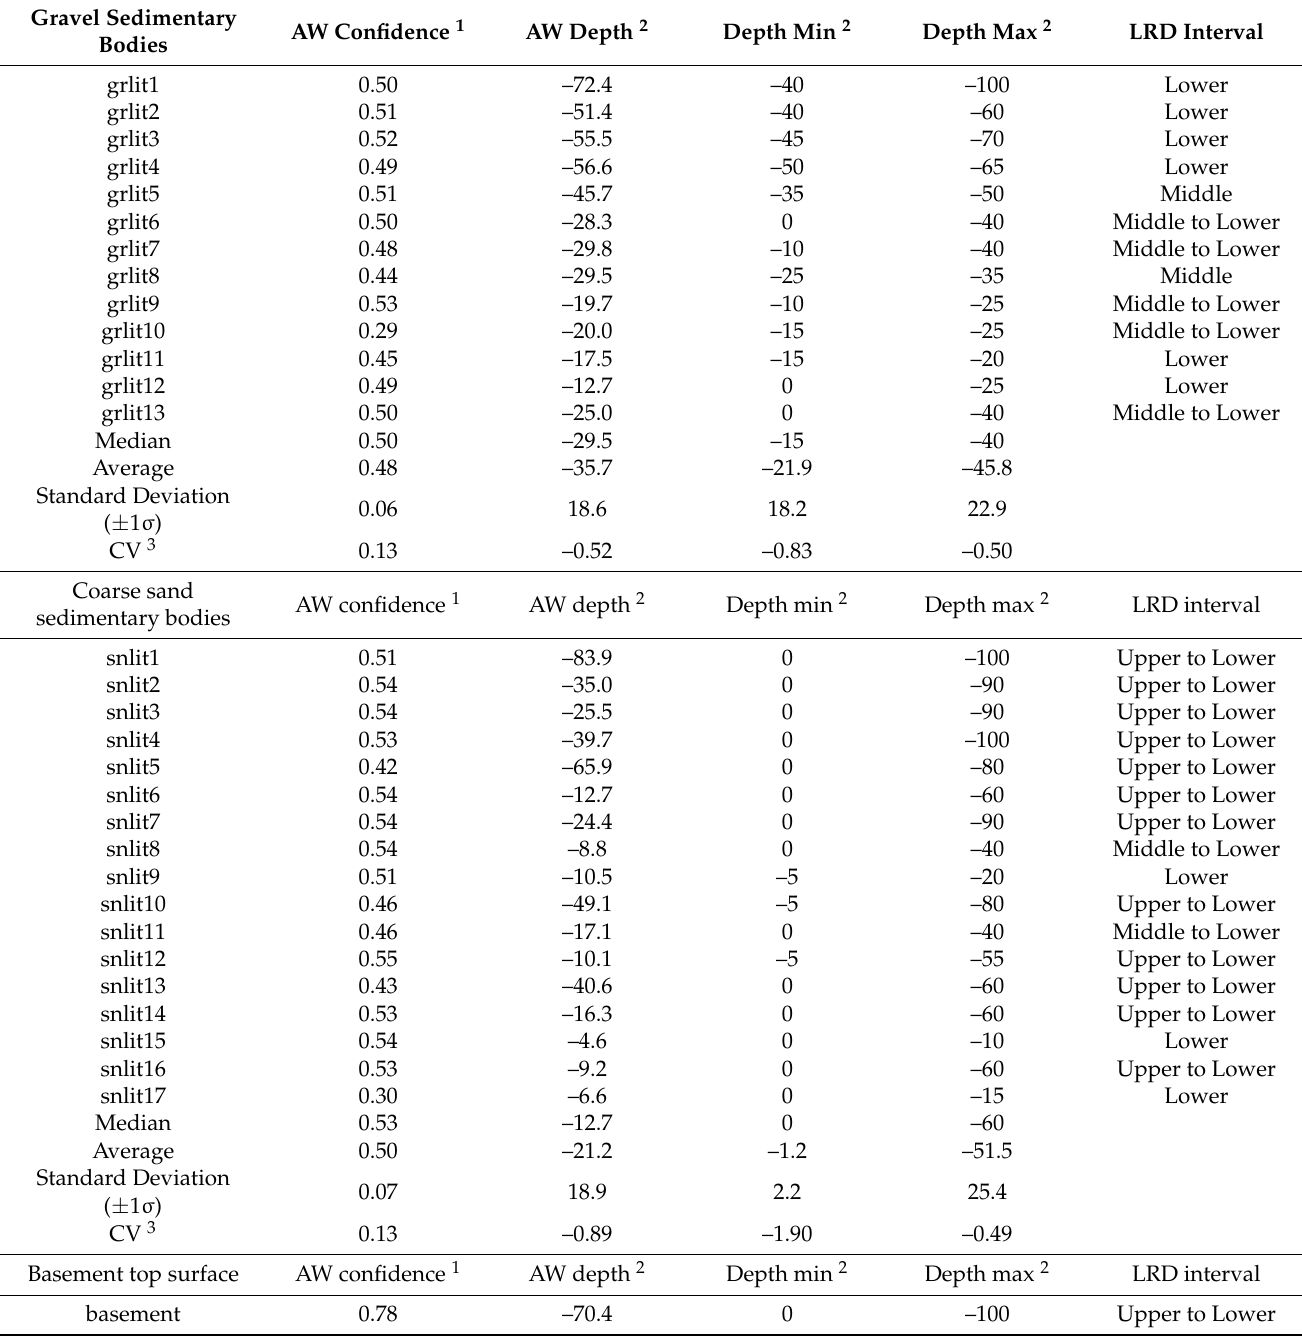
Table 1. Basic metrics and statistics of the KNN prediction confidence of the observed (and defined) gravel sedimentary bodies, coarse sand sedimentary bodies and the basement top surface in the onshore